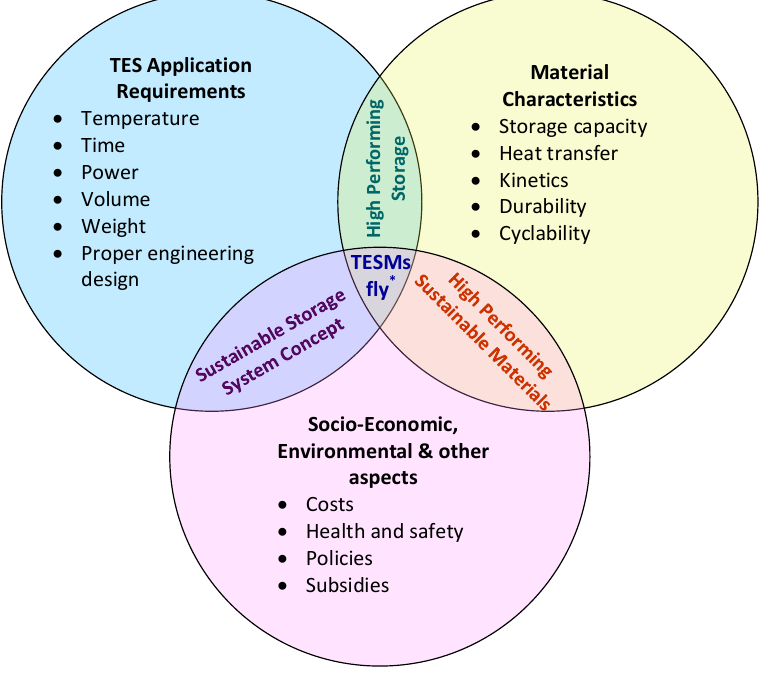
Figure 13. The ultimate goal. The key elements and synergies required to truly-enable TESMs to fly * on the market by realizing high performing and sustainable TES with sustainable TESMs.